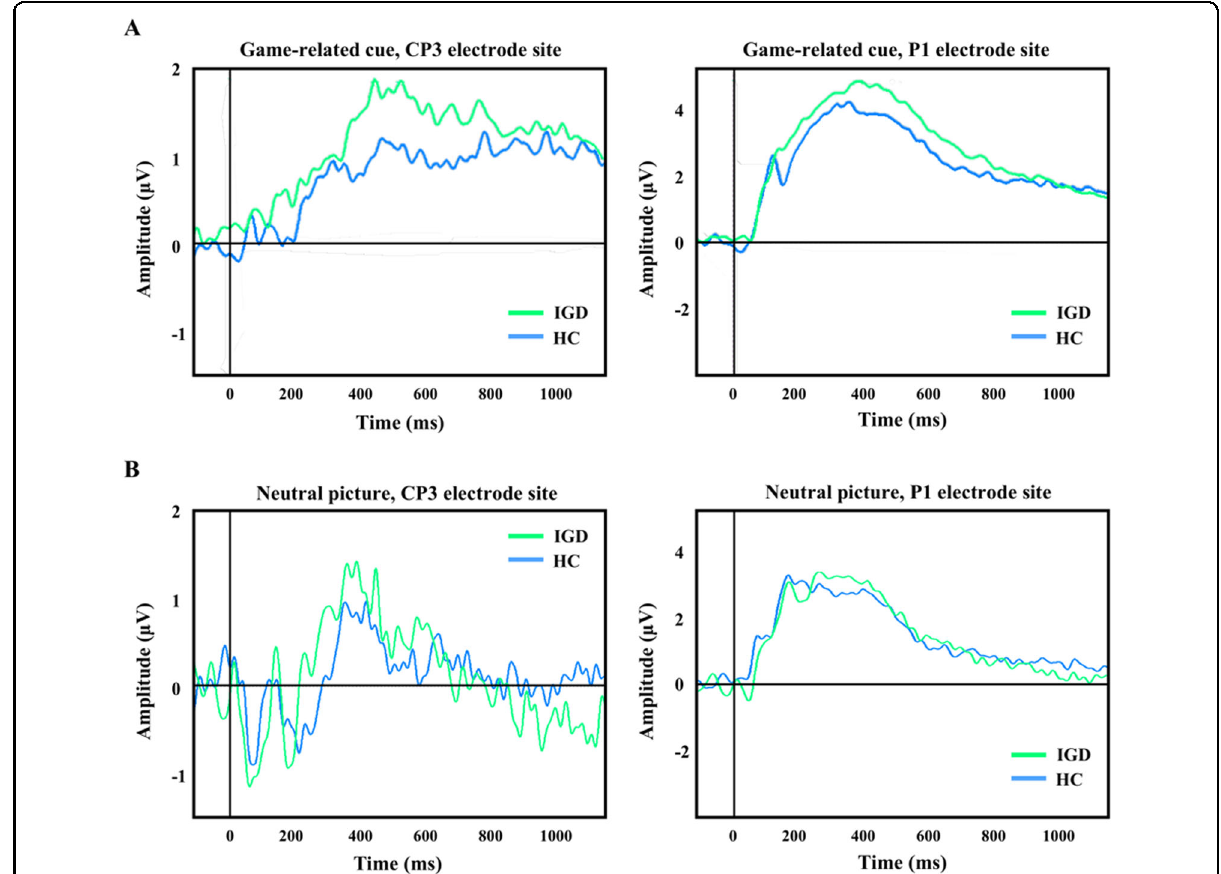
Fig. 1 Grand-averaged late positive potential (LPP) waveforms elicited by the game-related and neutral pictures. A Grand-averaged LPP waveformselicited by the game-related pictures at the CP3 and P1 electrode sites. B Grand-averaged LPP waveforms induced by the neutral pictures at the CP3 and P2 electrode